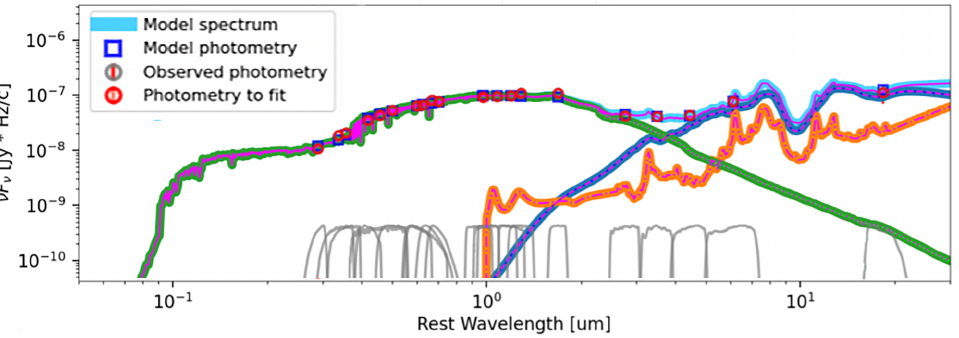
Figure 16. Heavily obscured AGN fit for 3D-HST 10260 (z = 0.279), from Lyu et al. [182]. For this galaxy, the stellar photospheric emission is dominant at wavelengths short of 2 µ m. The measure- ments at 4.5–24 µ m cannot be fitted by a combination of stellar and PAH band emission, as would be expected for a star-forming galaxy, because a normalization of the star-forming template in the 4.5–8 µ m range makes it exceed the 24 µ m point by nearly a factor of three. The strongly ob- scured AGN template (heavy blue line) is a far better fit; it drops sufficiently rapidly toward shorter wavelengths to be insignificant in the optical and